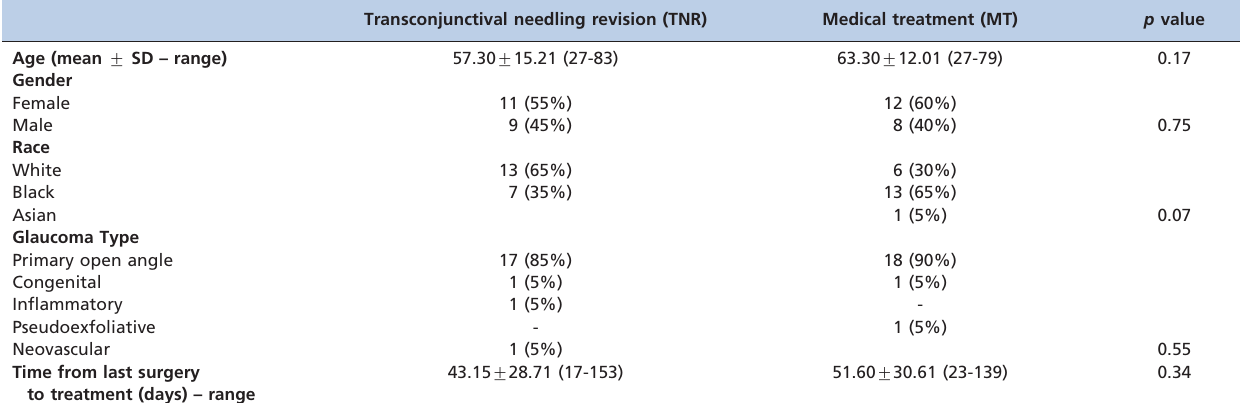
Table 1 - Demographic data and characteristics of the study population.